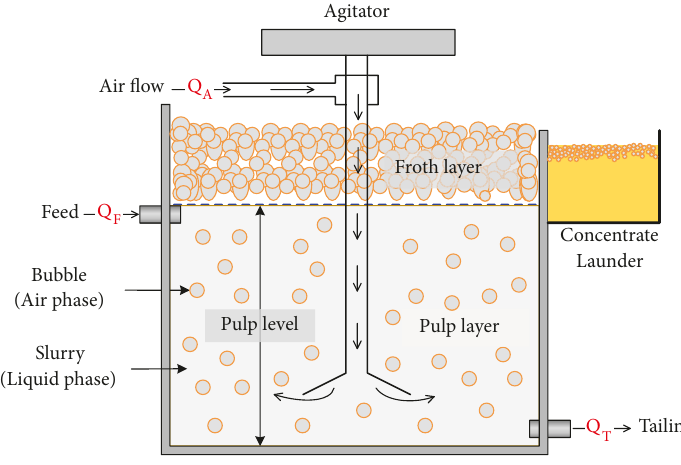
Figure 2: Structure of a sulphur flotation cell.